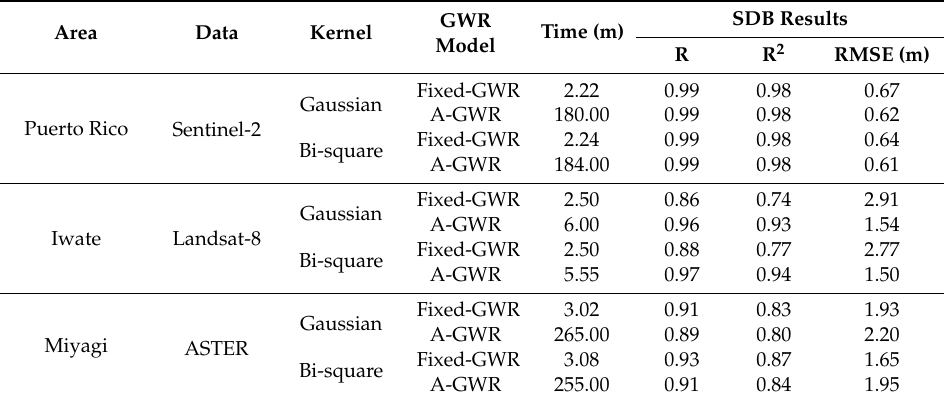
Table 3. Performance of i.image.bathymetry in case studies 1, 2, and